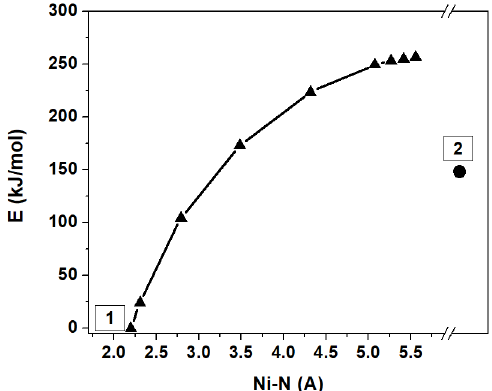
Figure 7. Prediction of DTG curve for [Ni(En) 3 ](ClO 4 ) 2 decomposition obtained at a lower heating rate of 2.5 °C·min − 1 using the models of Table 4: ( a ) variant 1 and ( b ) variant 2.